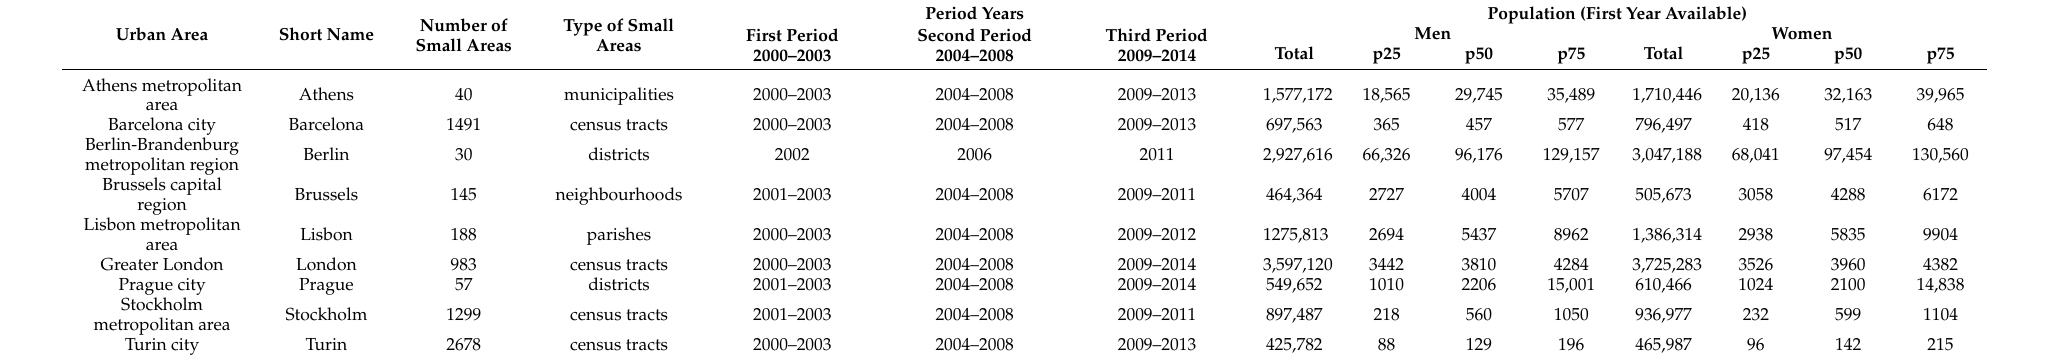
Table 1. Description of the nine European urban areas: number and type of small areas, period years, and total population (first- p25-, second -p50-, and third -p75- quartiles of the population by small area for men and